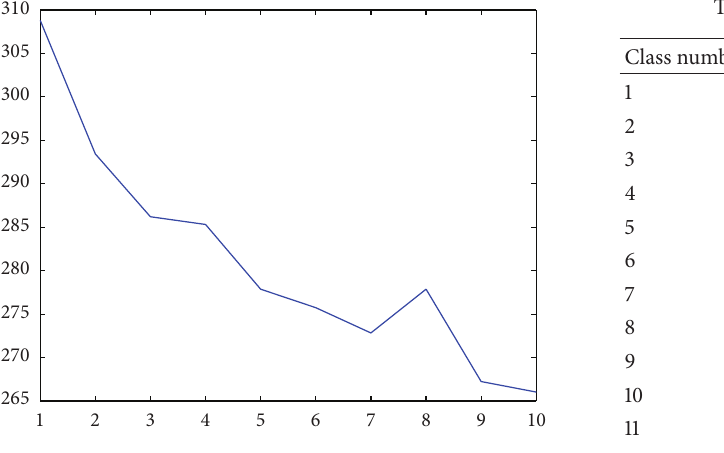
Figure 3: Residual sum function of squares change with the order.